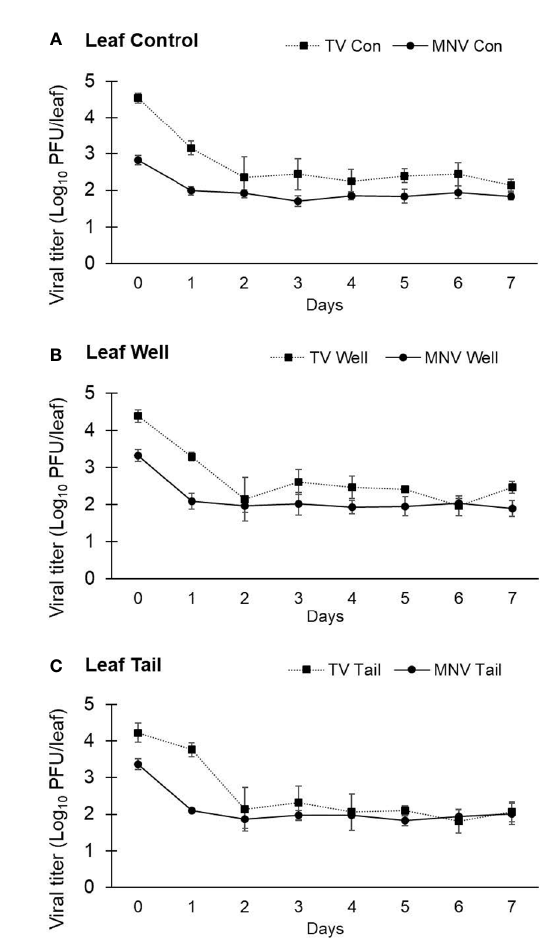
FIGURE 4 Impact of water quality on the recovery of infectious human norovirus surrogates from the surface of romaine lettuce leaves. Infectivity of TV and MNV on the surface of lettuce leaves was assessed for 7 days (trial 1) when suspended in (A) ultrapure water, (B) well water, and (C) tail water. Viral titer is reported as PFU/leaf. Data points are the average of six replicates. Error bars represent ±standard deviation.